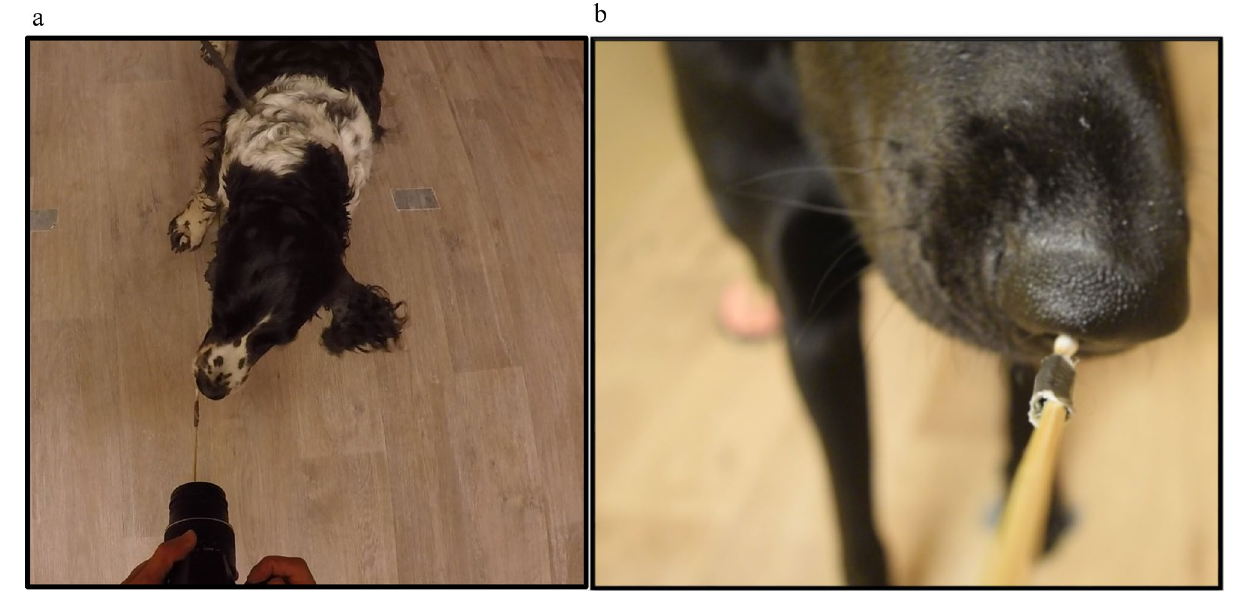
Figure 3. ( a , b ) The set-up of the sniffing aparatus used to test domestic dogs’ interest in the scent collected from the bottom of the feet for male and female dogs ( a ) and a view from the camera recording the dogs’ sniffing duration and nostril use for ( b